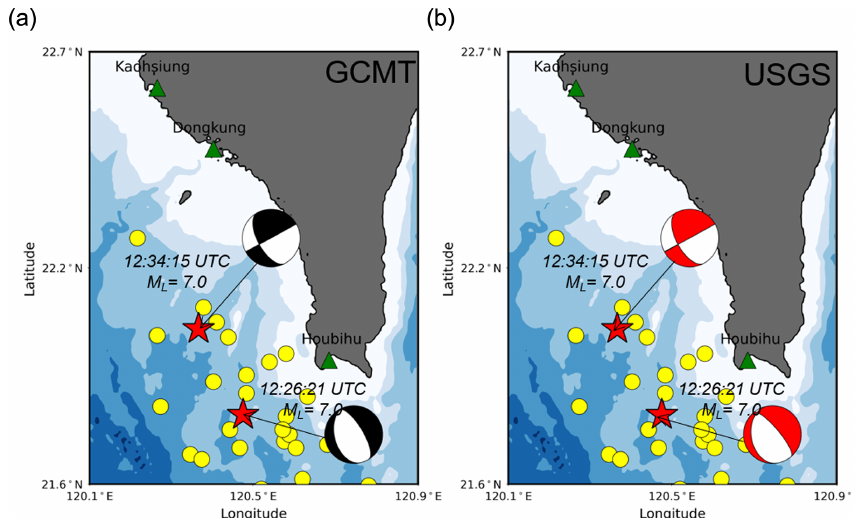
Figure 2. The tectonic settings of the 2006 earthquake doublet. The red stars denote the epicenters of the successive earthquakes. The beach balls denote the focal mechanisms of the two earthquakes estimated from the GCMT and USGS moment tensor solutions. The yellow circles show the aftershock distribution for 1d from the USGS earthquake catalog. The green triangles represent the locations of the CWB tide gauge